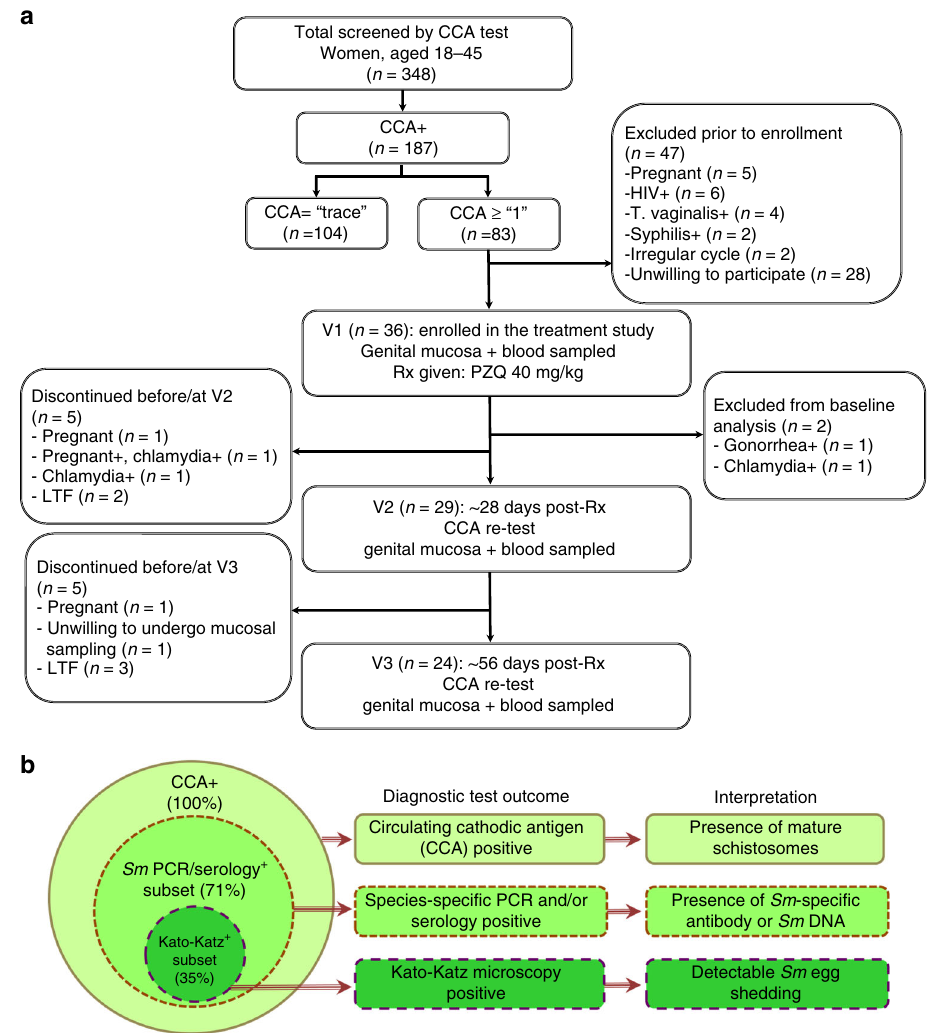
Fig. 1 Overview of the study recruitment scheme and schistosomiasis testing outcomes. a Screening and recruitment fl ow chart. See Methods for detailed study inclusion criteria and Supplementary Table 2 for the CCA scoring scheme. b Proportion of all participants who were CCA-positive (34/34), were tested positive by Sm PCR and/or Sm SEA serology (24/34) or shed Sm eggs as determined by microscopic analysis of stool samples (12/34) at baseline analysis. See Supplementary Table 3 for details. Source data are provided as a Source Data fi le. CCA: circulating cathodic antigen; PZQ: praziquantel;